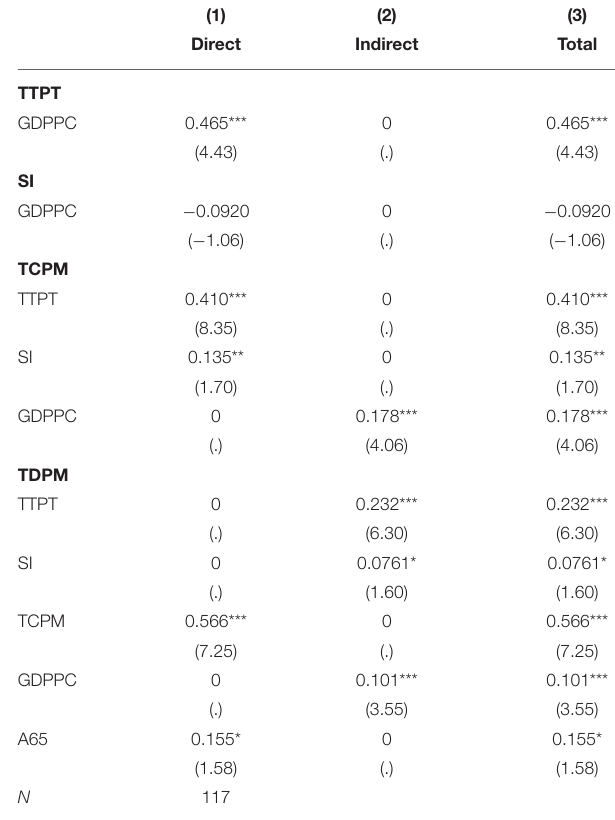
TABLE 7 | Direct, indirect, and total effects determinants of COVID-19 deaths via A65.